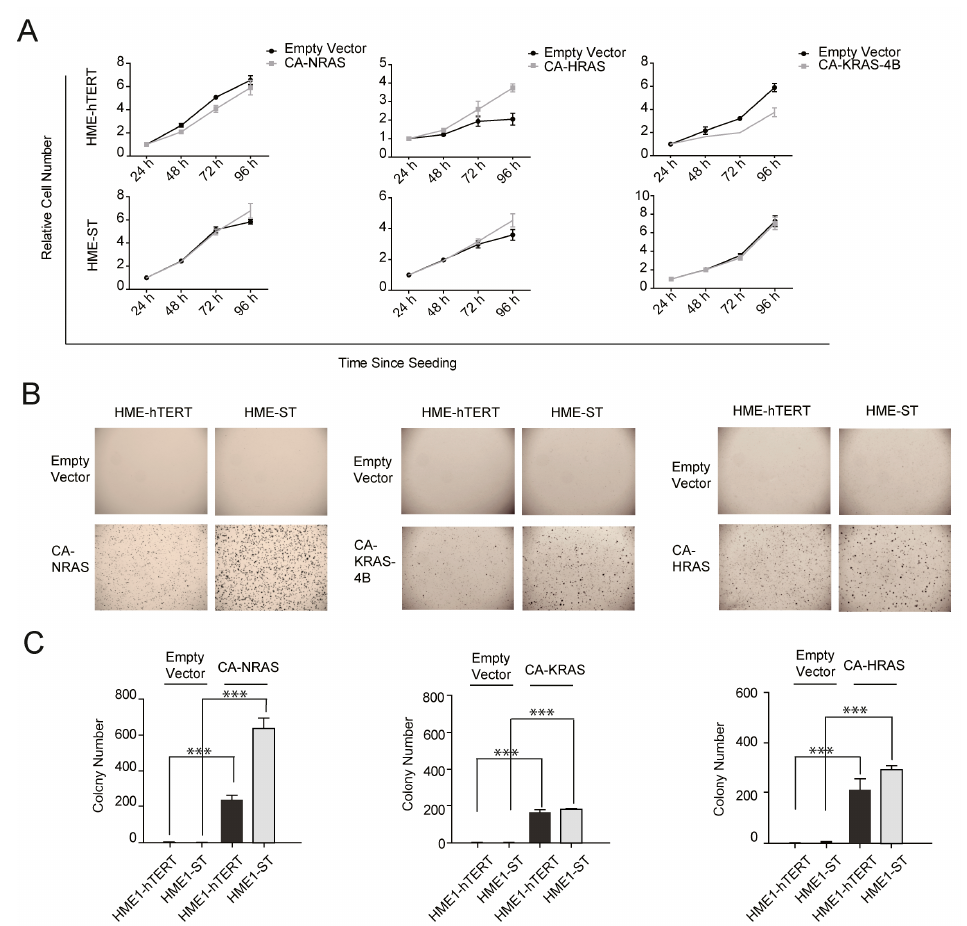
Figure 1. The proliferation phenotypes of various human mammary epithelial cells in adherent culture or in anchorage-independent soft-agar growth condition. ( A ) Proliferation of human mammary epithelial (HME) cells at different stages of transformation cultured under adherent condition. HME-hTERT: immortalized human mammary epithelial cells; HME-ST: HME-hTERT also expressing SV40 small T antigen. Each isoform of constitutively active RAS was introduced into the two cell lines; grey lines and black lines represent the cells with or without the expression of the indicated isoforms of constitutively active RAS: CA-NRAS, CA-HRAS and CA-KRAS. ( B ) Representative microscopic images documenting colony formation of the indicated HME cells, as in panel A, cultured in soft agar for 11 days. ( C ) Quantitation of the data from ( B ), summed from three representative microscopic fields for each condition. Data are presented as mean ± SD; *** p ≤ 0.001 (Student’s t -test). All studies presented above have been repeated twice with similar